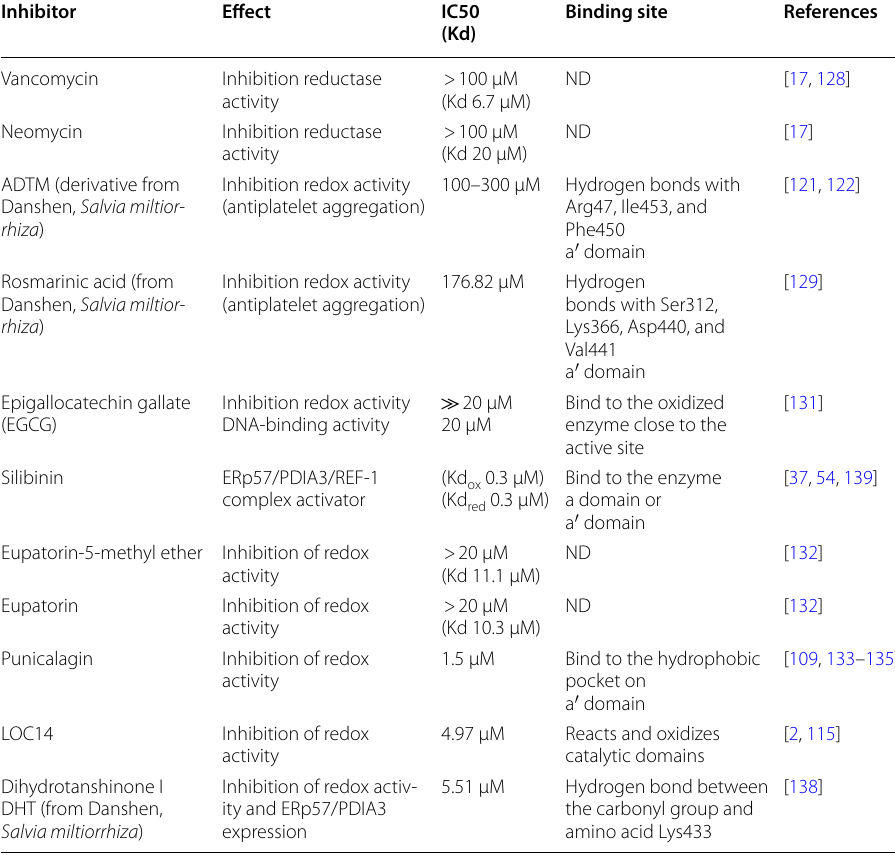
ND not detected; Kd ox Kd ERp57/PDIA3 oxidized; Kd red Kd ERp57/PDIA3